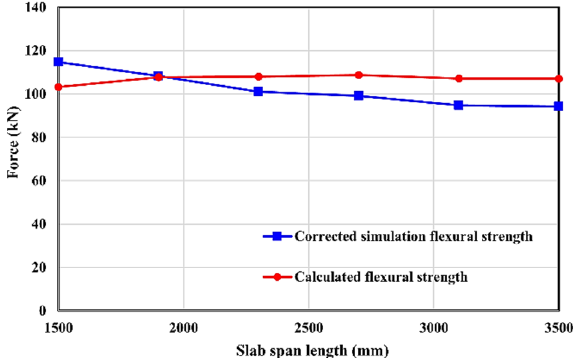
16 of 24 ( f ) Model S6 Figure 21. Stress and yield conditions for slab span length models. Table 1 summarizes values of the simulation flexural strength, the corrected flexural strength considering the overestimation of the FEM simulation, the corresponding calcu- lated values of 𝛽 , and the calculated flexural strength using Equation (6) considering 𝛽 for each model. It can be seen that values of 𝛽 were observed close and ranging from 0.94~0.99, which was in coincidence with that observed in the stress condition of reinforc- ing bars. Thus, the calculated value is not identical, but still close to that measured in the FEM analysis for all models. Additionally, a comparison between relationships of slab span length-corrected simulation flexural strength and slab span length-calculated flex- ural strength for slab span length models is shown in Figure 22 It can be seen that even though there was still a slight deficiency between the calculated and simulated values, the calculated values by applying the 𝛽 coefficient can give a reasonable and conservative prediction for the flexural strength for these models. Table 1. FEM results for slab span length models. Model Slab Span Length (mm)